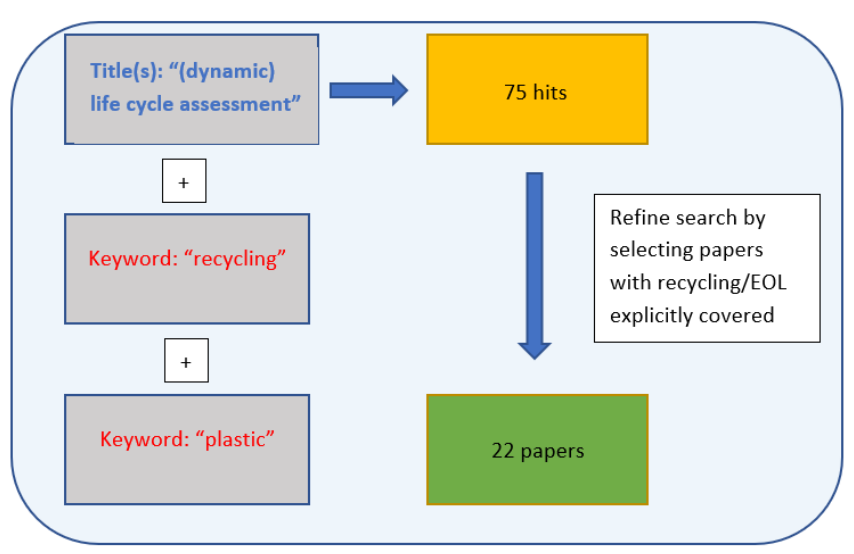
Figure 4. Selection criteria for reviewed papers. Table 2. Overview of recent papers covering end-of-life (EoL)/recycling of plastics from 2015–2020 in terms of methodo- logical choices. aLCA: attributional LCA; cLCA: consequential LCA.